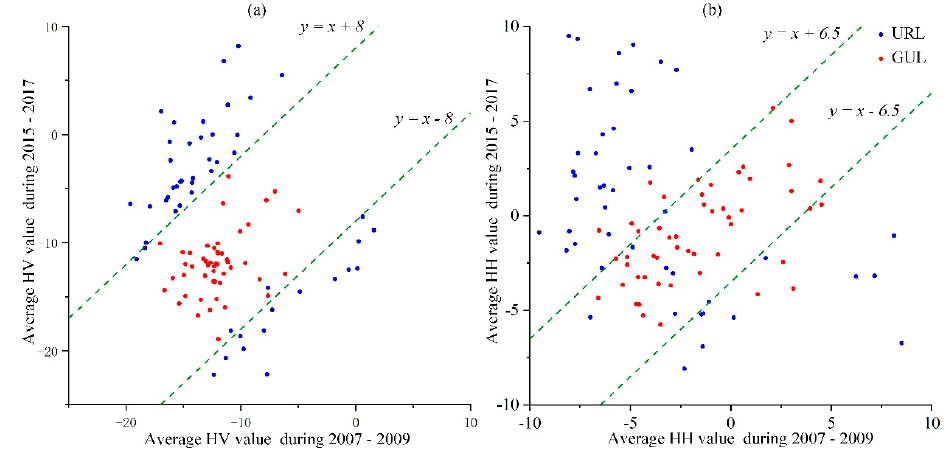
Figure 5. Two-dimensional scatter plots of ( a ) average horizontal transmit/vertical receive (HV) gamma-naught and ( b ) average horizontal transmit/horizontal receive (HH) gamma-naught from 2007–2009 and 2015–2017 in the study area.